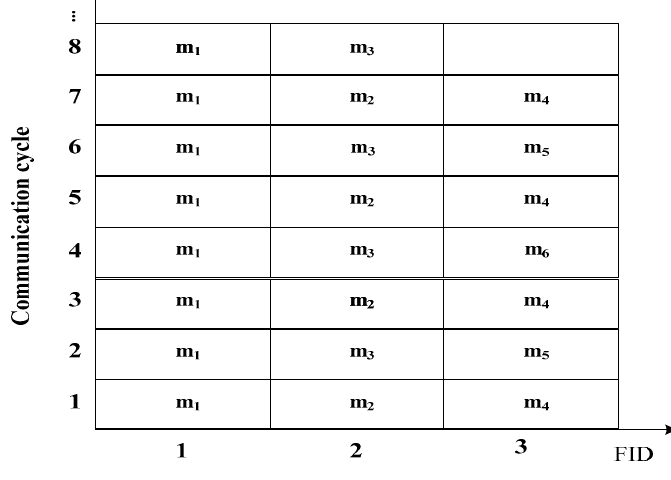
Figure 5. Message schedule for an ECU.